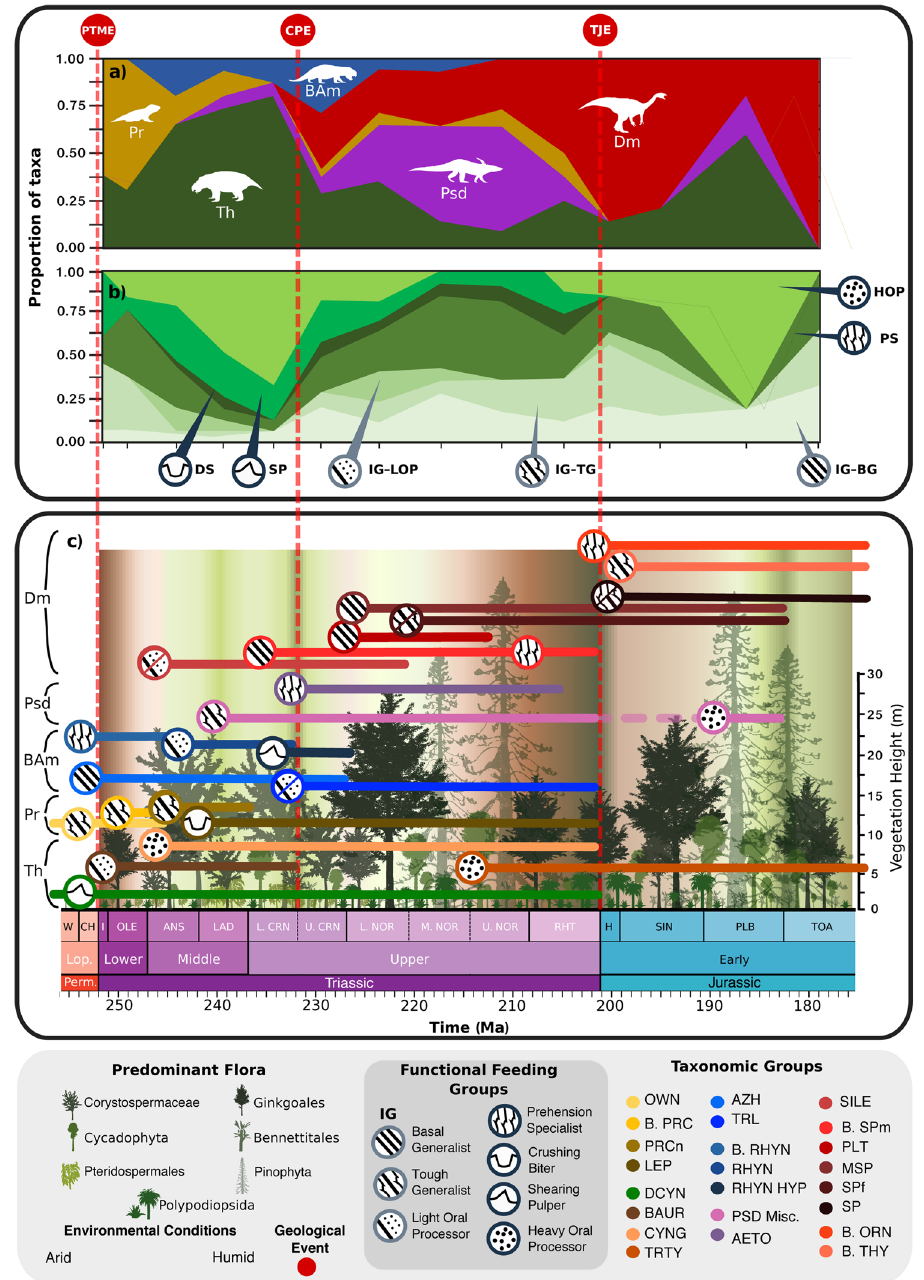
Fig. 3 Functional feeding groups of early Mesozoic herbivores through time. a The relative species richness of different clades through time. b The relative richness of different functional feeding groups through time. c Distribution of functional feeding groups across different taxonomic groups and subgroups of herbivores is indicated. Clade and guild changes shown at the midpoints for each stage/substage in panels a and b . Temporal ranges of the groups are based on fi rst and last fossil occurrence dates, highlighting the span of ecological prominence for each group. Environmental changes from arid to humid shown by background colour gradient. Predominant vegetation 4,60,61 and characteristic vegetation (relative) height 93,94 indicated by tree silhouettes. Geological Events: PTME Permian-Triassic mass extinction, CPE Carnian Pluvial Event, TJE Triassic-Jurassic mass extinction, Timebins: ANS Anisan, CH Changhsingian, H Hettangian, I Induan, L CRN Lower Carnian, L NOR Lower Norian, LAD Ladinian, Lop Lopingian, M. NOR Middle Norian, OLE Olenekian, PLB Pliensbachian, RHT Rhaetian, SIN Sinemurian, TOA Toarcian, U. NOR Upper Norian, W Wuchiapingian, Feeding Functional Groups: BG basal generalist, DS durophagous specialist, HOP heavy oral processor, IG ingestion generalist, LOP light oral processor, PS prehension specialist, SP shearing pulper, TG tough generalist, Larger Clades: Dm Dinosauromorpha, Psd Pseudosuchia, BAm Basal Archosauromorpha, Pr Parareptilia, Th Therapsida, Taxonomic Groups: Parareptilia: OWN Owenettidae, B. PRC Basal Procolophonidae, PRCn Procolophoninae, LEP Leptopleuroninae, Therapsida: DCYN Dicynodontia, BAUR Bauriidae, CYNG Cynognathia, TRTY Tritylodontia, Archosauromorpha: ALLOK Allokotosauria, B. RHYN Basal Rhynchosauria, RHYN Rhynchosauridae, RHYN HYP Hyperodapedontinae, PSD Misc Miscellaneous Pseudosuchia, AETO Aetosauria, SILE Silesauridae, B. SPm Basal Sauropodomorpha, PLT Plateosauridae, MSP (non-sauropodiform) Massopoda, SPf (non-sauropod) Sauropodiformes, SP Sauropoda, B. ORN Basal Ornithischia, B. THY Basal Thyreophora, TRL Trilophosauria, All silhouettes created by S.S., but some are vectorised from artwork by Felipe Alves Elias (https://www.paleozoobr.com/) and Jeff Martz (United States National Park Service), available for academic use with attribution. NATURE COMMUNICATIONS| (2021) 12:2796 |https://doi.org/10.1038/s41467-021-23169-x|www.nature.com/naturecommunications